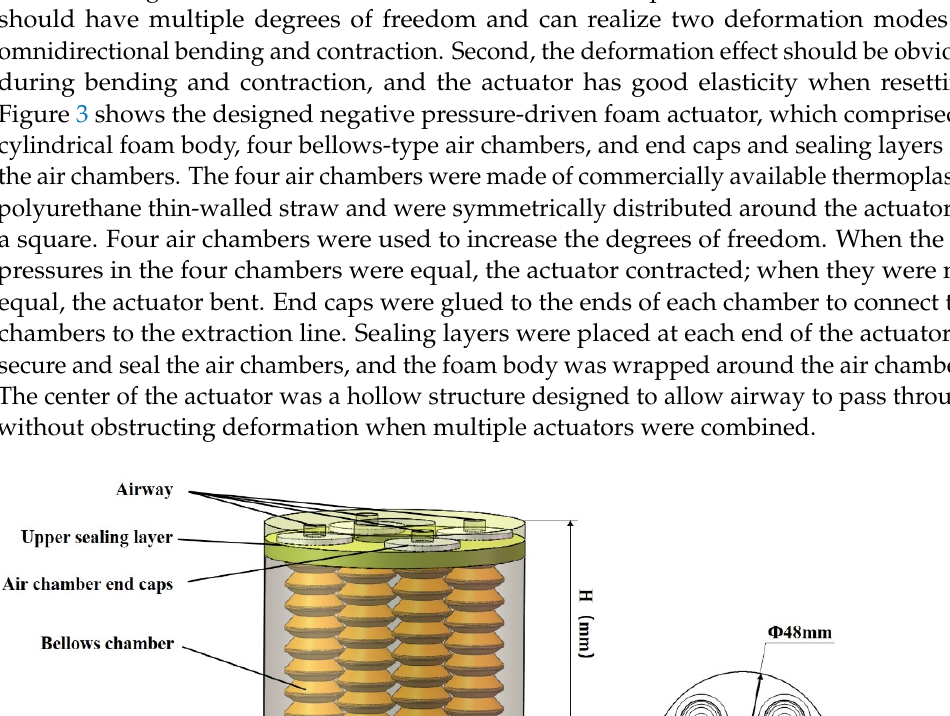
Figure 2. Stress–strain curves of foam materials under uniaxial compression. The inset shows the liner elastic region. Table 1. Statistical data of different foams at three strain rates.